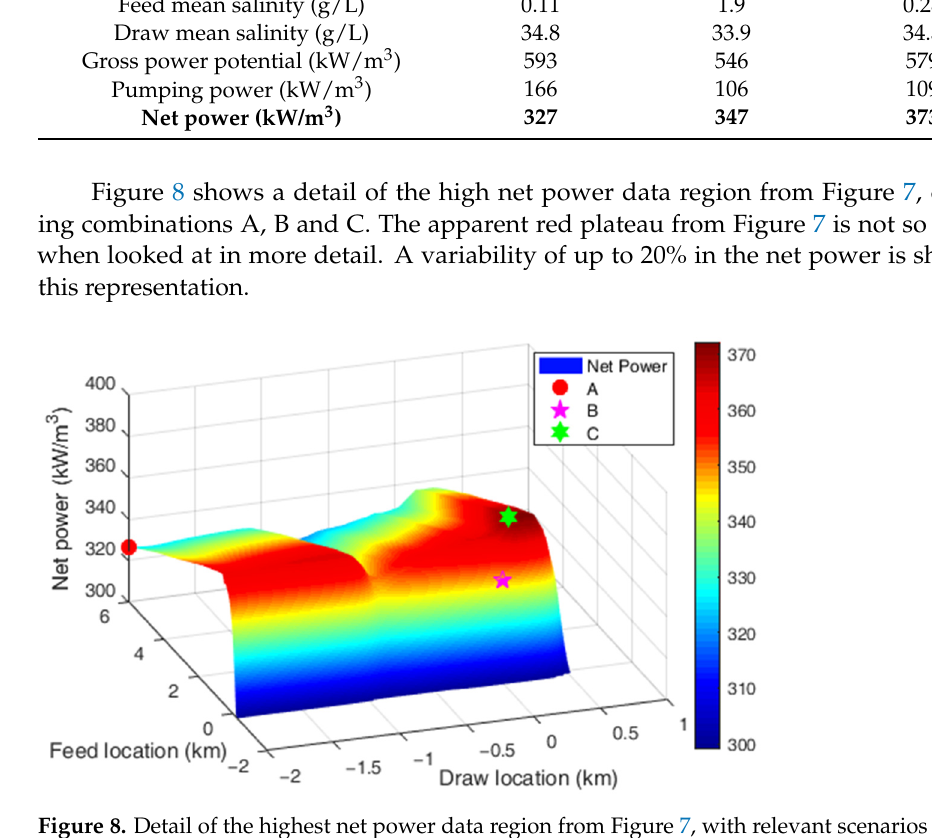
Figure 8. Detail of the highest net power data region from Figure 7, with relevant scenarios A, B and C from Table